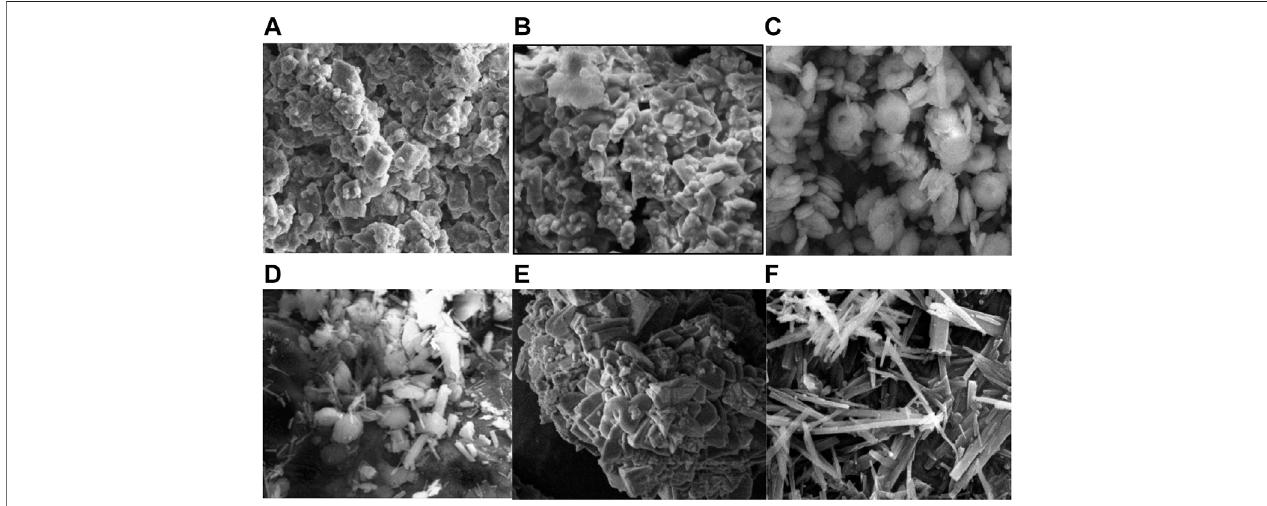
FIGURE 8 | Scanning electron microscopy (SEM) images of carbonate precipitation from group A. (A) CaCl 2 (FW); (B) CaCl 2 (SW); (C) Ca(CH 3 COO) 2 (FW); (D) Ca(CH 3 COO) 2 (SW); (E) Ca(NO 3 ) 2 (FW); (F) Ca(NO 3 ) 2 (SW).